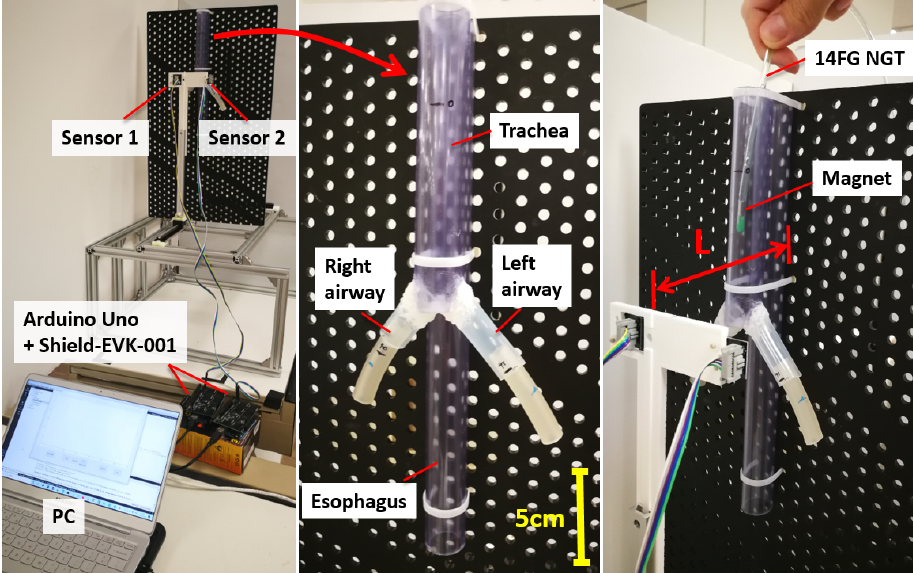
Figure 5. Mock-up esophagus and airway for the second experiment. The 14 FG NGT with a magnet is manually inserted into each path (esophagus, right airway, and left airway).